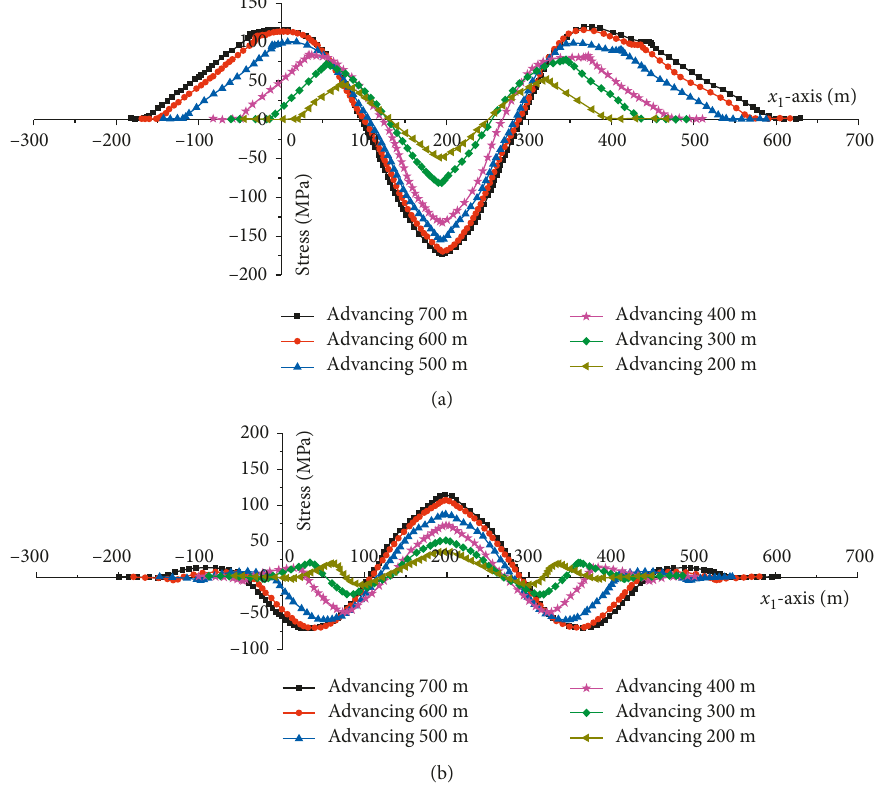
Figure 13: Additional axial stresses on the buried pipeline as the working face advancing: (a) axial stresses distribution on the top of the pipeline and (b) axial stresses distribution at the bottom of the